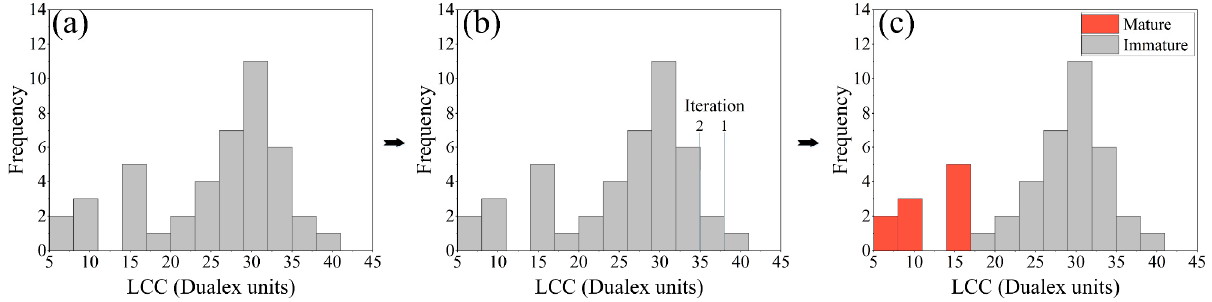
Figure 4. Soybean LCC and FVC anomaly detection methods: ( a ) P3-LCC image element histogram; ( b ) iterative process; ( c ) final results.